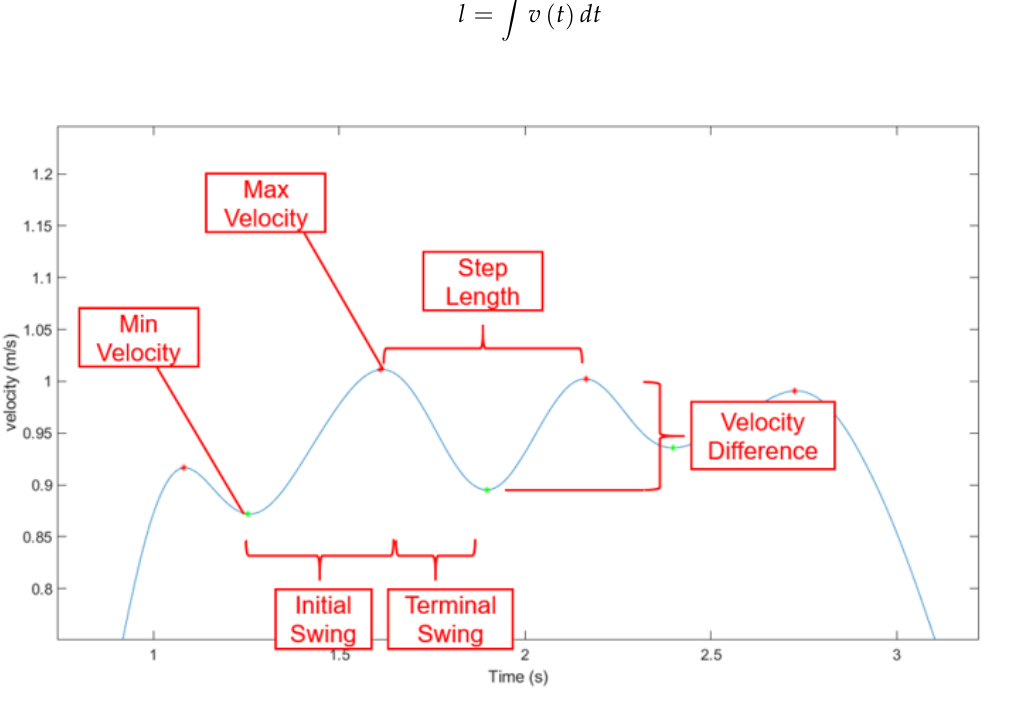
Figure 9. Velocity-time diagram of the walking period in the stable